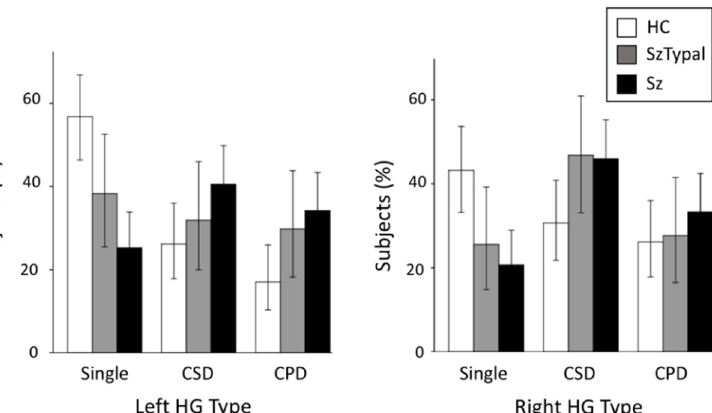
Figure 2. Distribution of Heschl’s gyrus (HG) gyrification patterns in schizophrenia (Sz), schizotypal (SzTypal), and healthy control (HC) groups. Error bars show 95% confidence intervals. CPD, complete posterior duplication; CSD, common stem duplication.